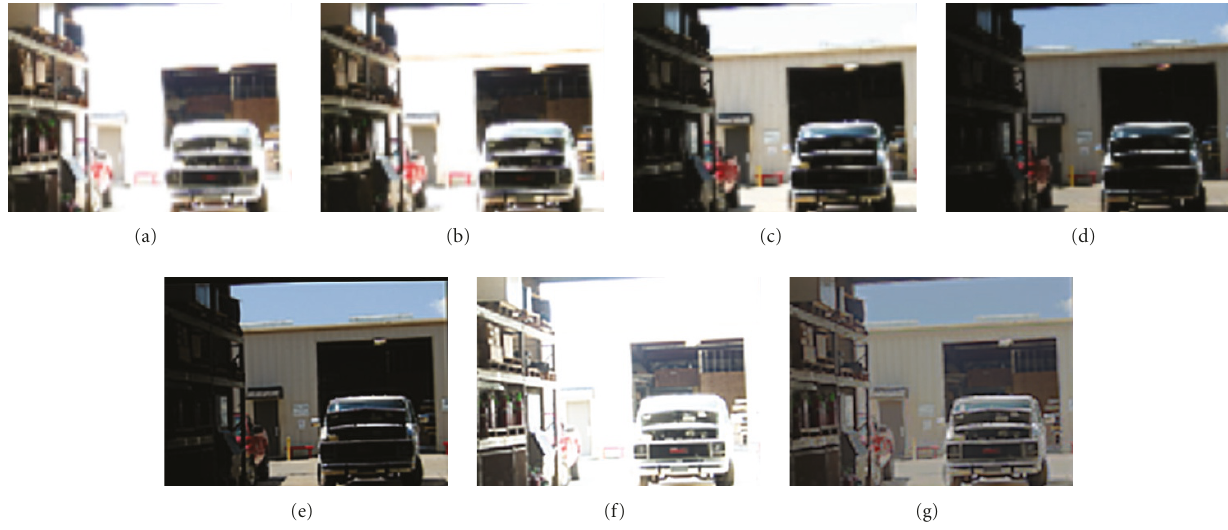
Figure 10: Cropped regions of observation and SR results: (a)–(d) input images; (e) SR when (d) is the reference image; (f) SR when (a) is the reference image; (g) SR using the technique presented in Section 3.2.